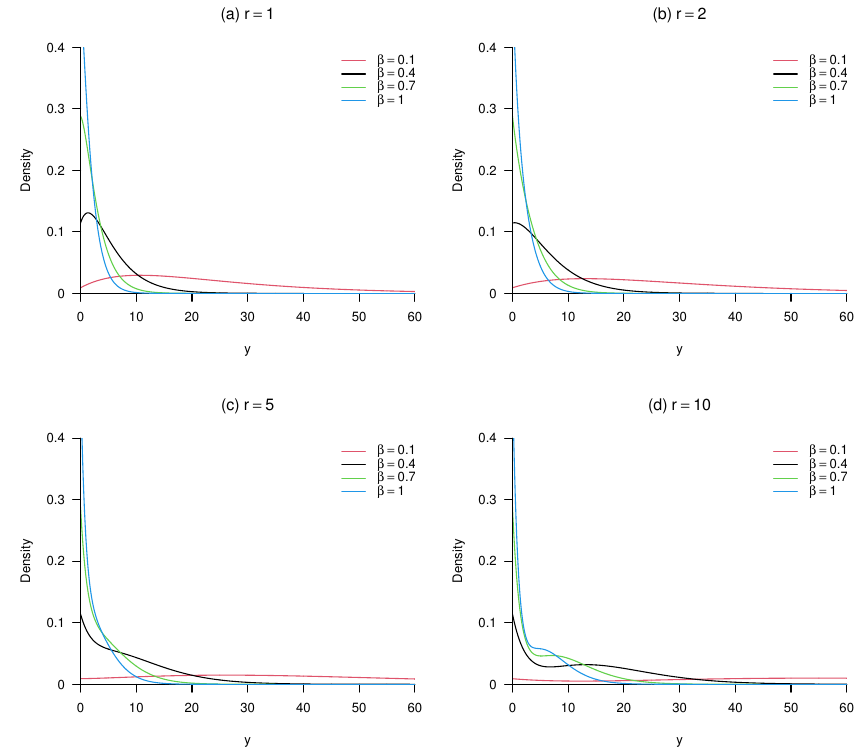
Figure 1. Shapes of the density function (6) for different values of ( β , r ) and b = 0.65.